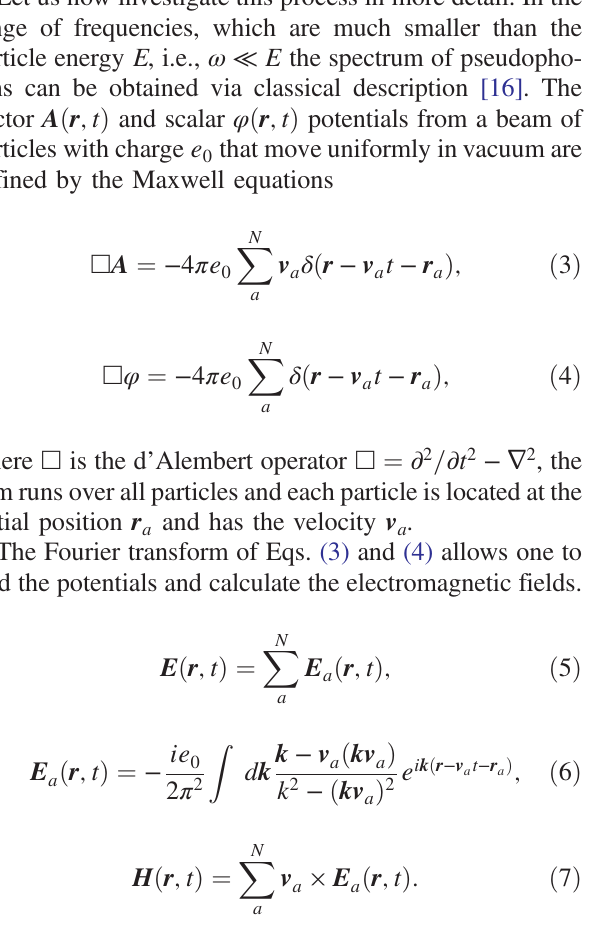
FIG. 2. Scheme of the photon generation in the case of PXR-EAD geometry. L ∼ 10 − 2 cm is the radiation absorption L abs